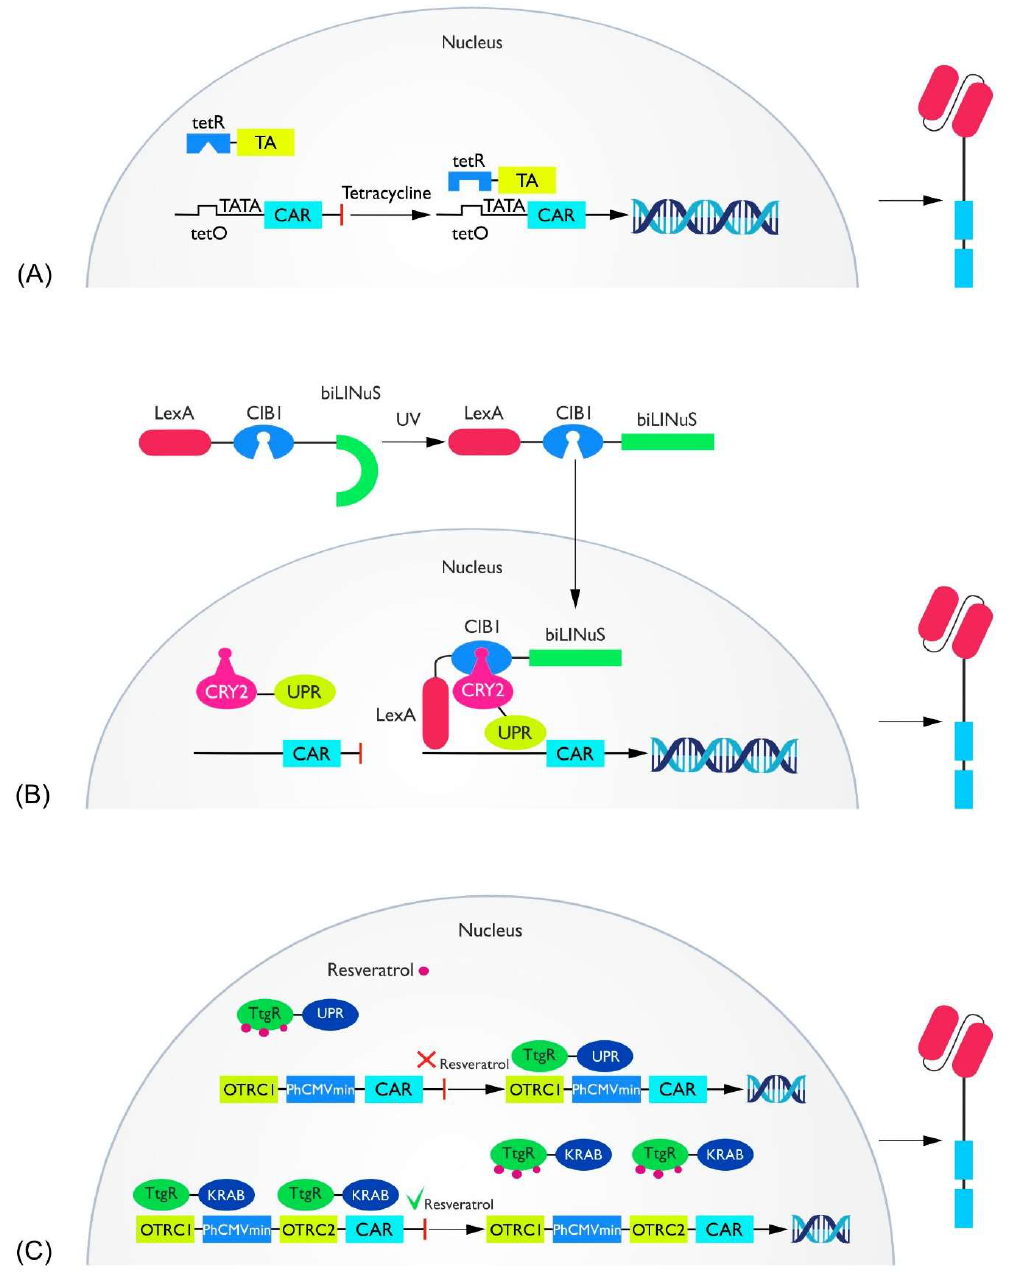
Figure 3. ( A ) The Tet system is activated upon administration of tetracycline. TetR binds to tetO, bringing the TA physically close to the TATA cassette. This activates transcription of the downstream gene—in this case, CAR. ( B ) The molecule composed of CRY2 and UPR is located in the nucleus, while the LexA-CIB1- biLINuS (LCB) molecule is located outside the nucleus. Upon UV delivery, biLINuS, which previously blocks the flow of LCB into the nucleus, changes spatial conformation and allows passage through the membrane. In the nucleus, LCB binds to CRY2-UPR (interaction of CIB1 with CRY2). LexA recognizes the binding site to DNA, and UPR activates transcription of the CAR gene. ( C ) Off switch at the top. When resveratrol is in the environment, it binds to TtgR, which blocks UPR attachment to DNA and activation of transcription. When resveratrol is removed, TtgR binds to Otrc1 and VPR activates PhCMVmin, leading to CAR expression. Off switch at the bottom. When resveratrol is absent, KRAB blocks PhCMV and transcription does not occur. When resveratrol is added, the attachment of TtgR to DNA is blocked, causing KRAB to dissociate (and, consequently, transcription